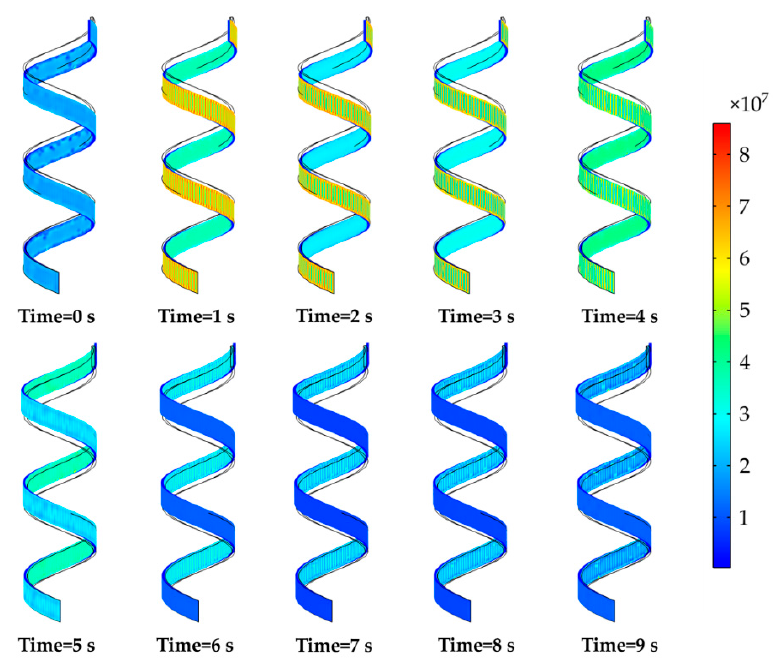
Figure 17. Cloud map of the von Mises stress.